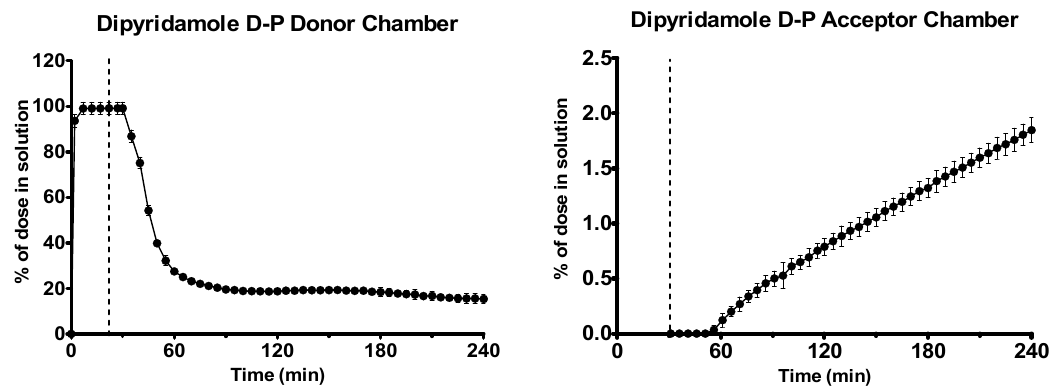
Figure 7. Drug release time profile for the dipyridamole dose equivalent to 5 mg API using the D-P apparatus. Left: Percentage release profile in the donor chamber. Right: Percentage release profile in the acceptor chamber. Dotted line indicates transition from gastric sector to intestinal sector. Each data point represents the mean ± SD ( n = 3).